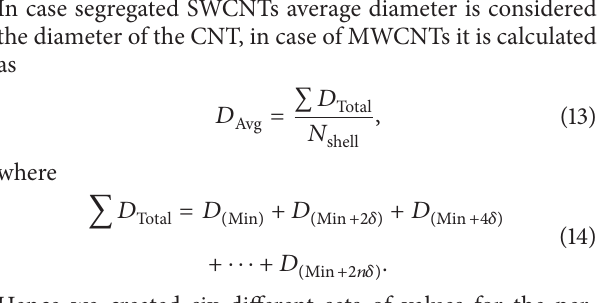
yield the best performance at all levels as shown in Figure